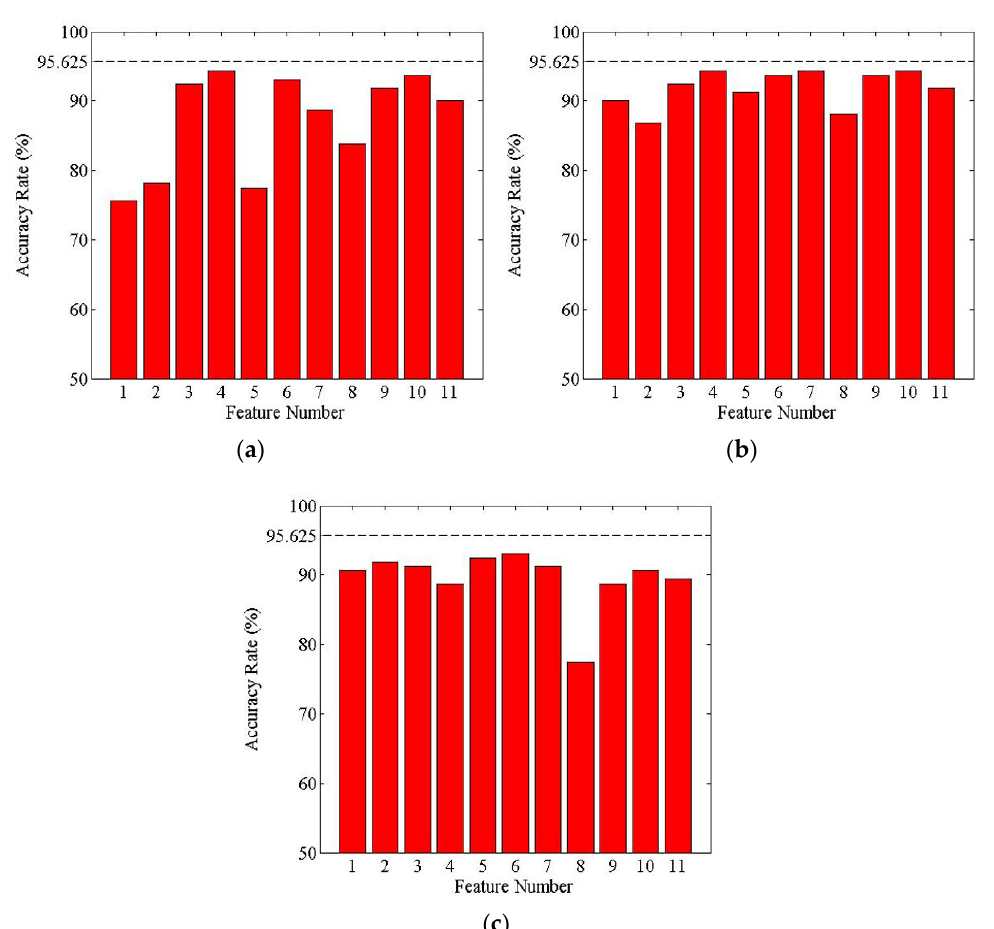
Figure 10. Ablation analysis of features in HSI space: ( a ) features of H component; ( b ) features of S component; ( c ) features of I component.1—Mean, 2—Median, 3—Maximum, 4—Minimum, 5—Common, 6—Range, 7—Variance, 8—Skewness, 9—Kurtosis, 10—Energy, 11—Entropy.